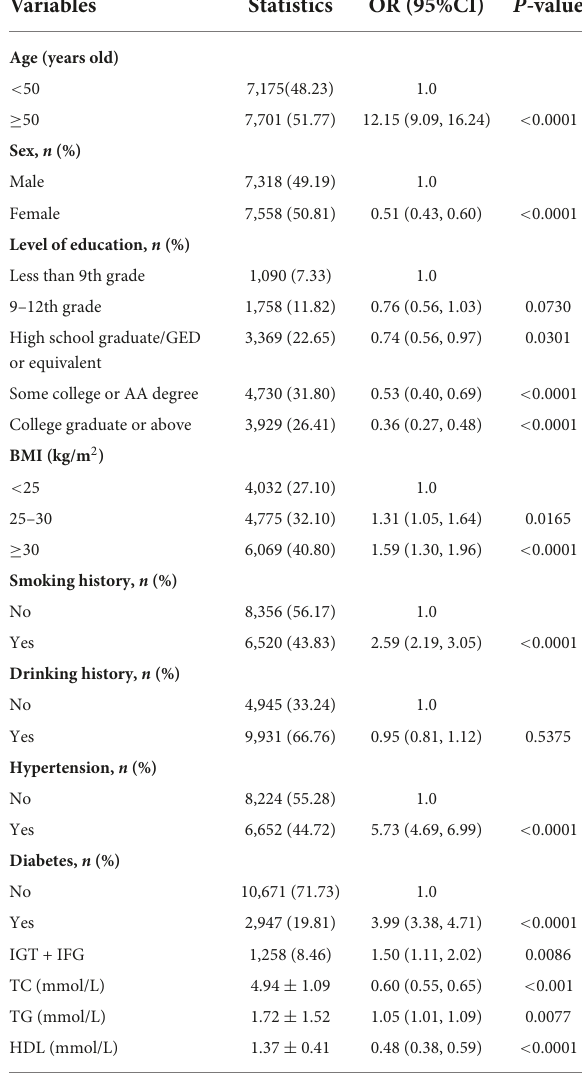
TABLE 3 Effects of various factors on myocardial infarction by univariate